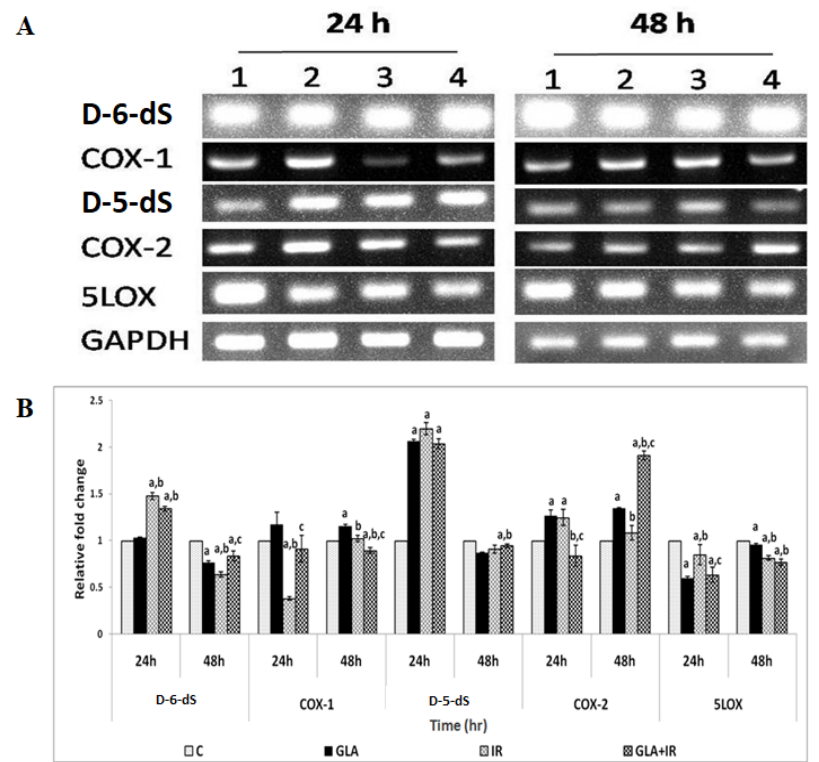
Figure 6. Effect of GLA and irradiation on genes of EFA (essential fatty acid) metabolic pathways (desaturases, COX-1, COX-2, and 5-LOX) in RAW 264.7 cells at 24 and 48 h post-irradiation ( A , B ). Values (n = 3) expressed as mean ± SEM. a , b , c Significant ( p < 0.01) when compared with control, GLA, and irradiation, respectively. 1, C; 2, GLA; 3, IR; and 4, GLA + IR. C, control; GLA, gamma- linolenic acid; IR, irradiation (2 Gy).